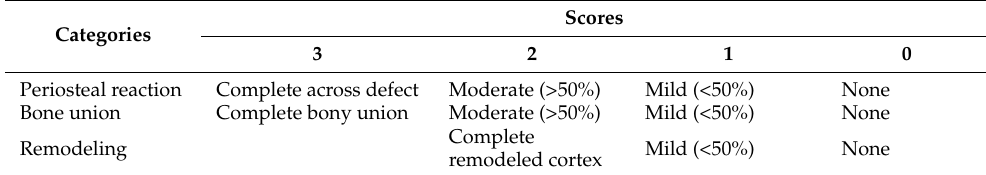
Table 1. Radiographic scoring system for fracture healing.